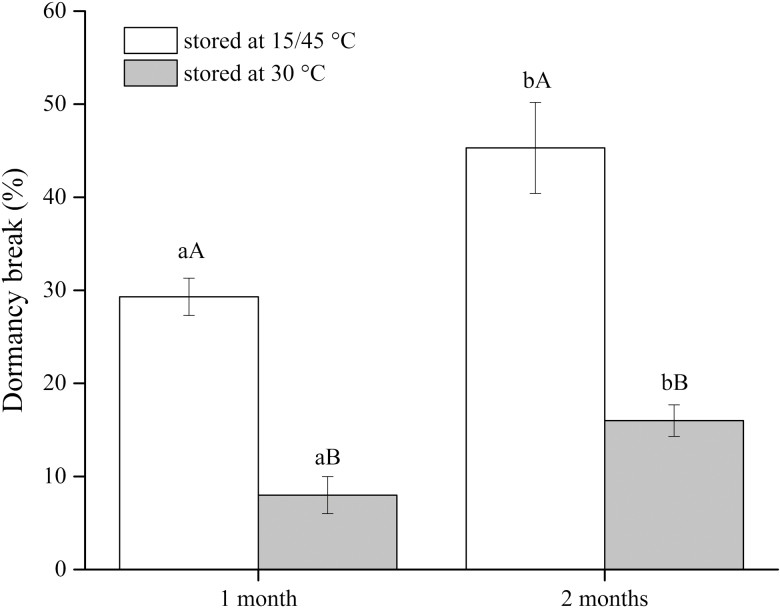
Mean percentage of Adenanthera pavonina seeds that broke dormancy and germinated after being stored for either 1 or 2 months at summer temperatures of 15/60 °C and subsequently moved to autumn temperatures of either 15/45 °C or constant 30 °C. Different lower-case letters denote a significant difference between storage temperature after storing at 15/45 °C. Different upper-case letters denote a significant difference between 15/45 and 30 °C after 1- and 2-month storage period.